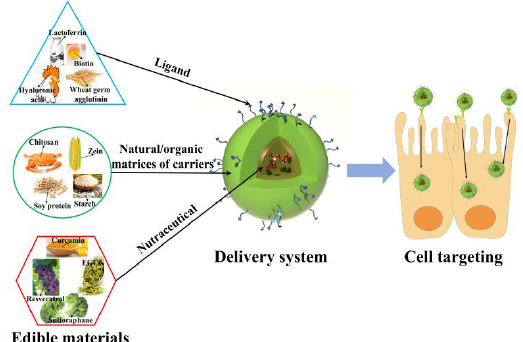
Figure 1. Structure diagram of cell-targeted delivery systems constructed of edible materials such as a ligand, carrier, and nutraceutical.